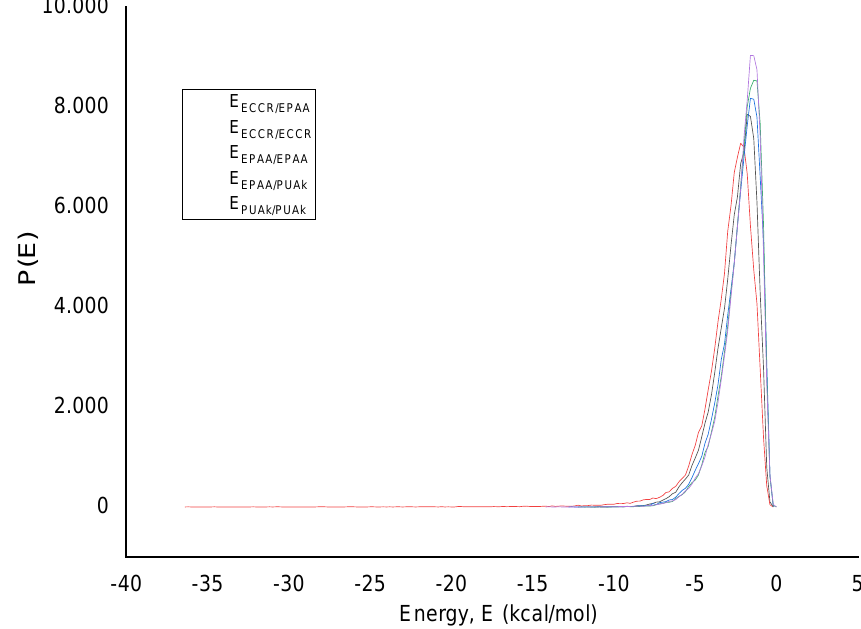
Figure 11. Mixing energy distribution plot. Table 8. Blend of the interacting systems: energies are in kcal mol −1. Base Figure 10. Three-dimensional plots of HOMO, LUMO, and σ-chart.